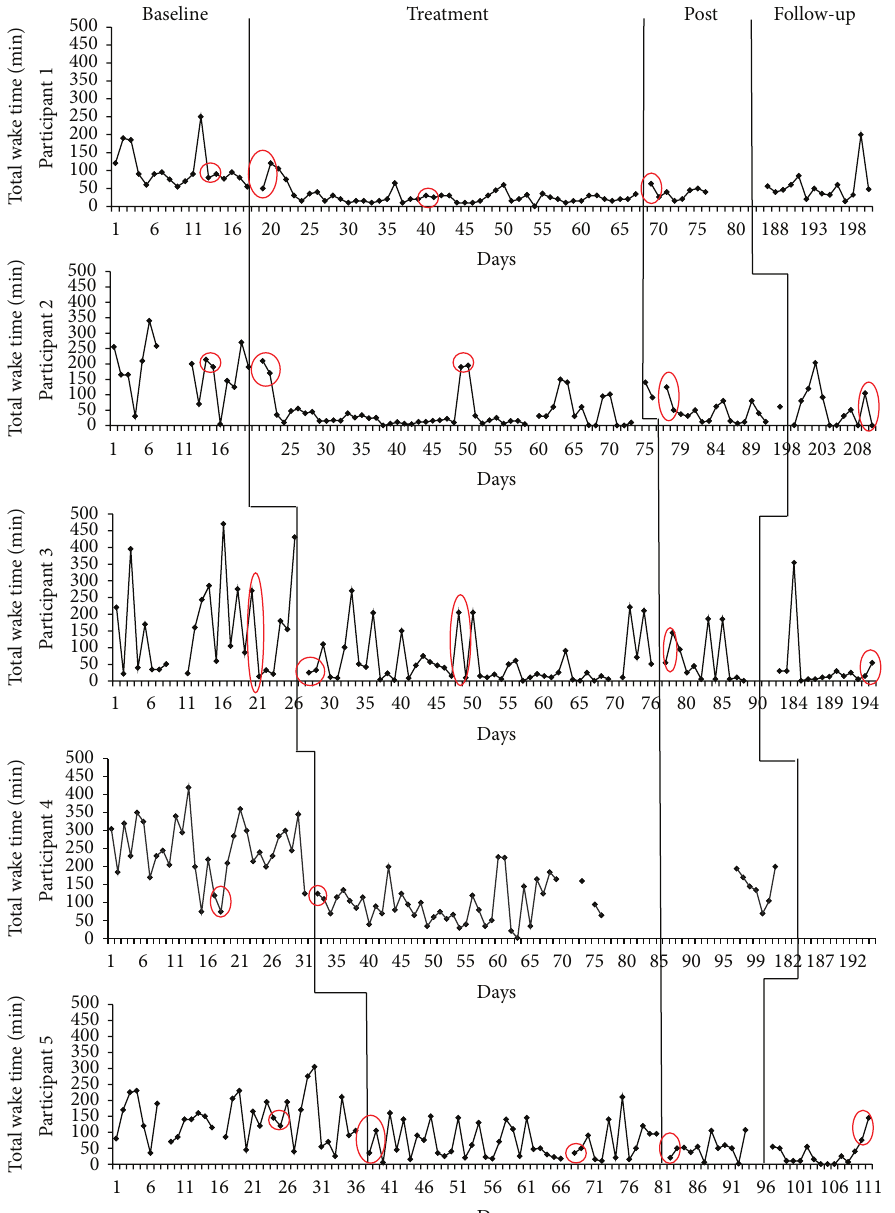
Figure 2: Daily total wake time course for each participant. Circled data correspond to PSG nights.